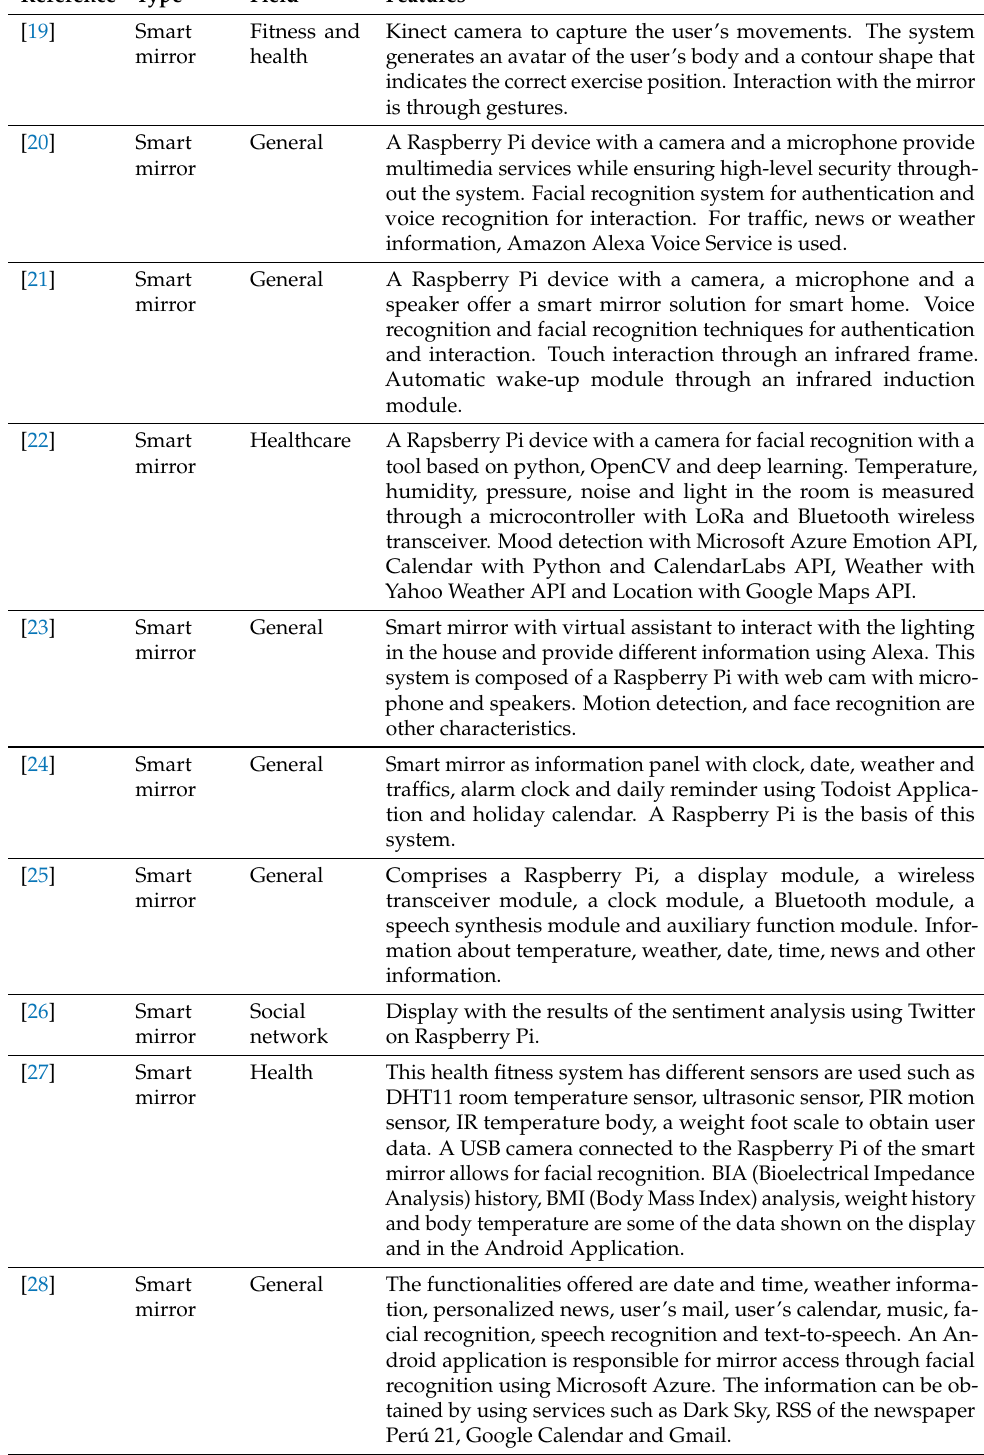
Table 1. Review of smart mirror platforms with a potential application in active